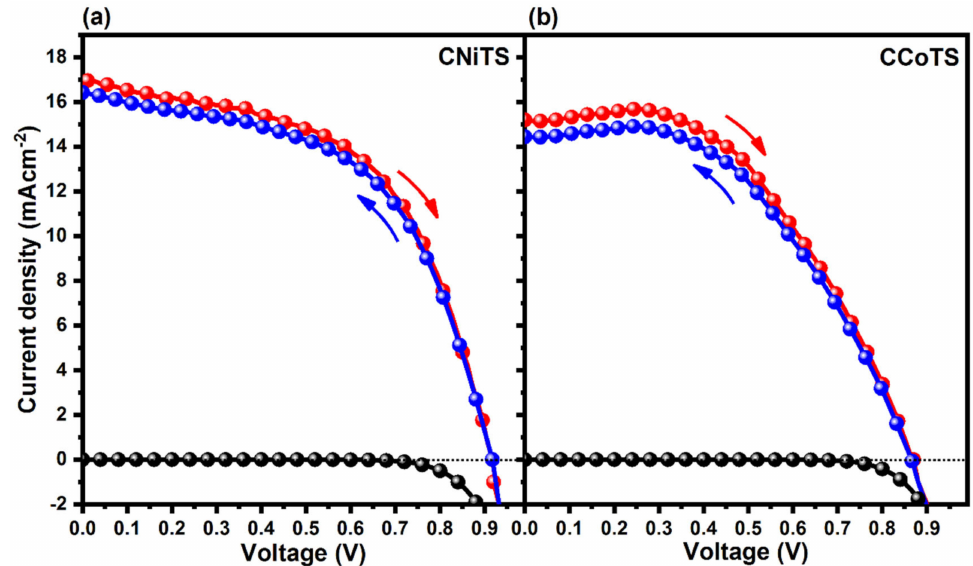
Figure 4. Record current density-voltage (J-V) curves for the ( a ) CNiTS and ( b ) CCoTS-based PSCs, in forward and backward directions with a 50 mVs − 1 scan rate, under 100 mWcm − 2 AM 1.5 G illumination and in the